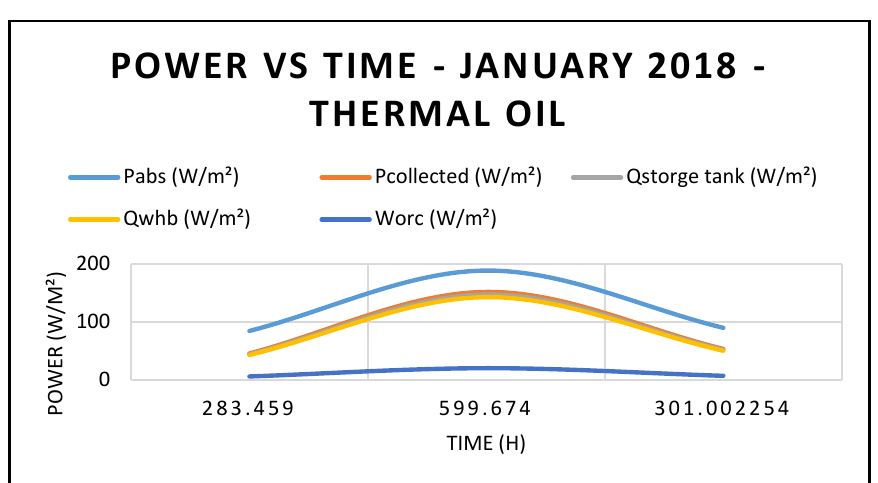
Figure 4. CSP hybrid system results with thermal oil as base fluid. Appl. Syst. Innov. 2019 , 2 , x FOR PEER REVIEW